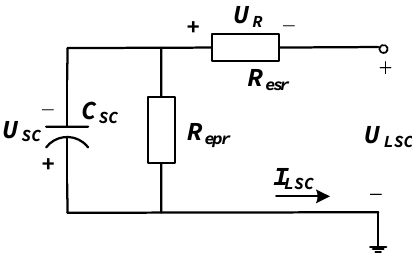
Figure 5. Supercapacitor equivalent electric circuit. C SC , capacitor; R epr , self-discharging loss; R esr , charging/discharging resistance I LSC , load current of the supercapacitor; U LSC , load voltage of the supercapacitor; U SC , terminal voltage of the supercapacitor; U R , ohm resistance voltage.